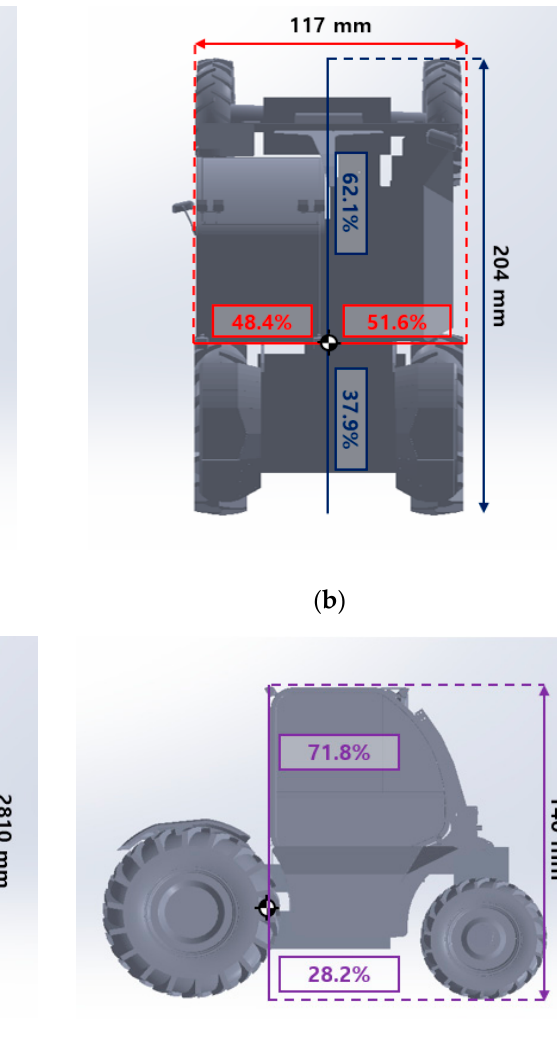
( b ) Figure 6. Measurement of axle weight of the miniature tractor: ( a ) Front axle; ( b ) Rear axle. Table 2. Specifications of the miniature tractor. Overall Dimensions (Length/Width/Height (mm))